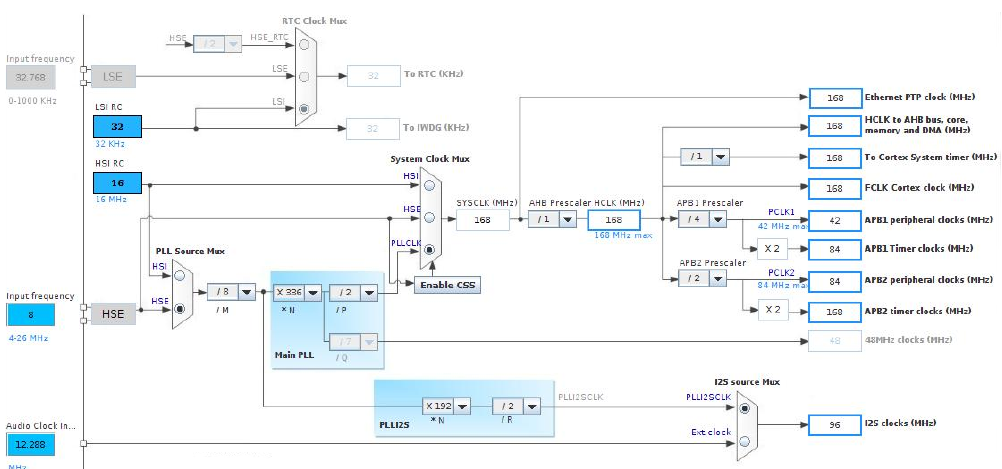
Figure 12. Clocks configuration in STM32F407VG SoC for PDM